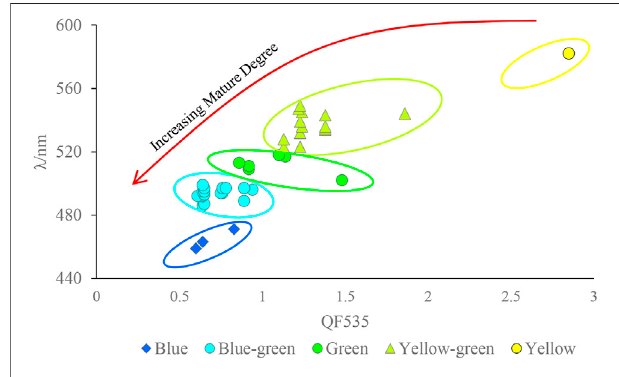
FIGURE 7 | Cross-plot of QF535 and λ max values for single oil inclusions in the FGSR reservoir.